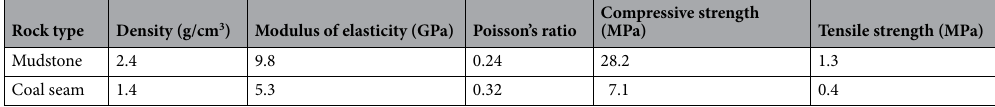
Table 4. Summary of mudstone and coal seam mechanical parameters.